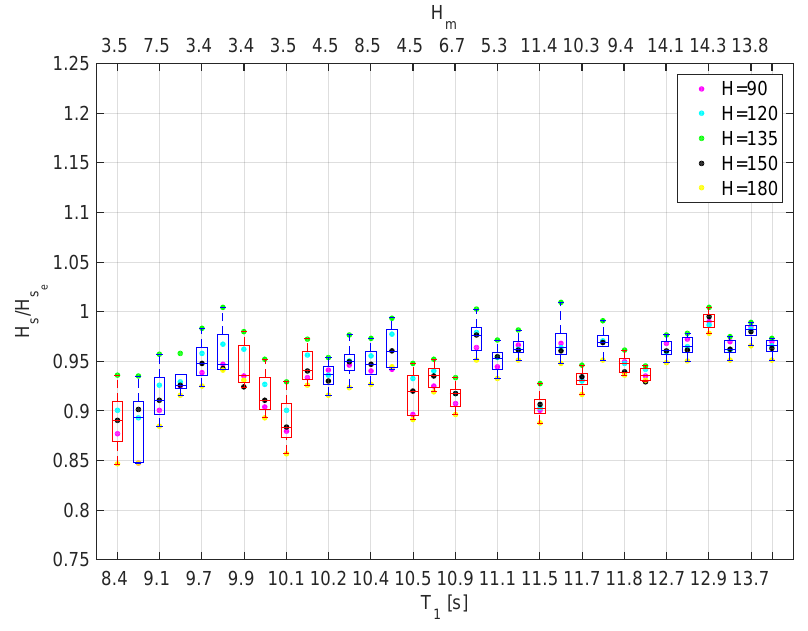
Figure 5. Box-plot showing the ratio between the estimated and measured significant wave height, obtained by means of the conventional